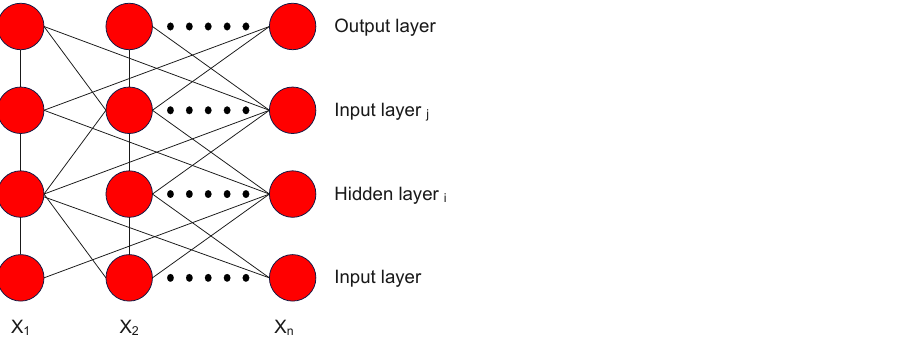
Figure 3. Multilayer feed-forward network with an input layer, two hidden layers, and an output layer